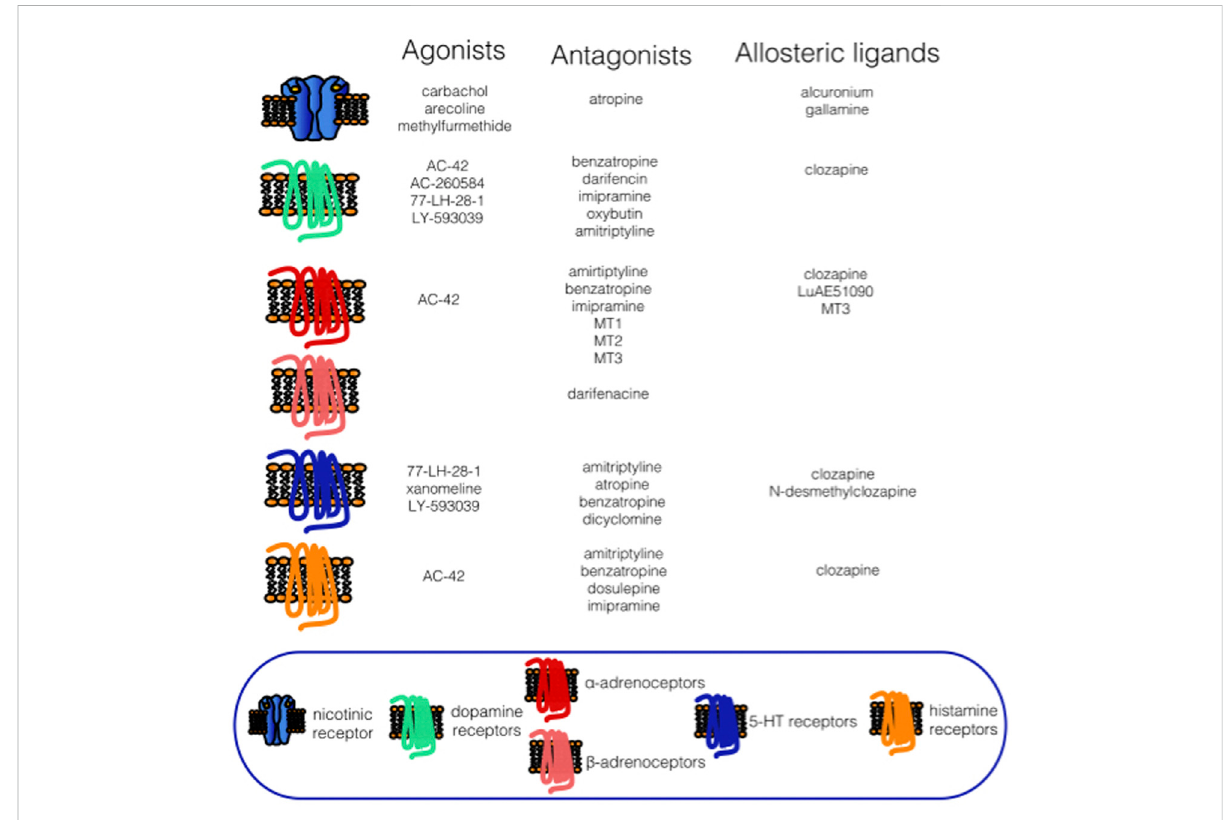
FIGURE 1 The main receptor targets of muscarinic agonists, antagonists and allosteric ligands. See the legend